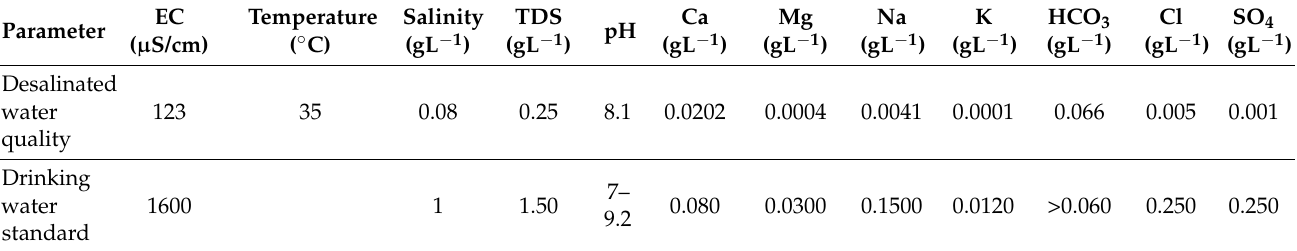
Table 4. Desalinated water quality in the year 2014